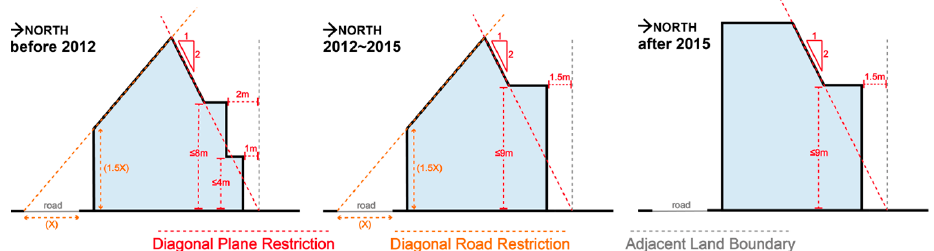
Figure 3. Recent evolution of Korea’s Diagonal Plane Restriction for daylight.